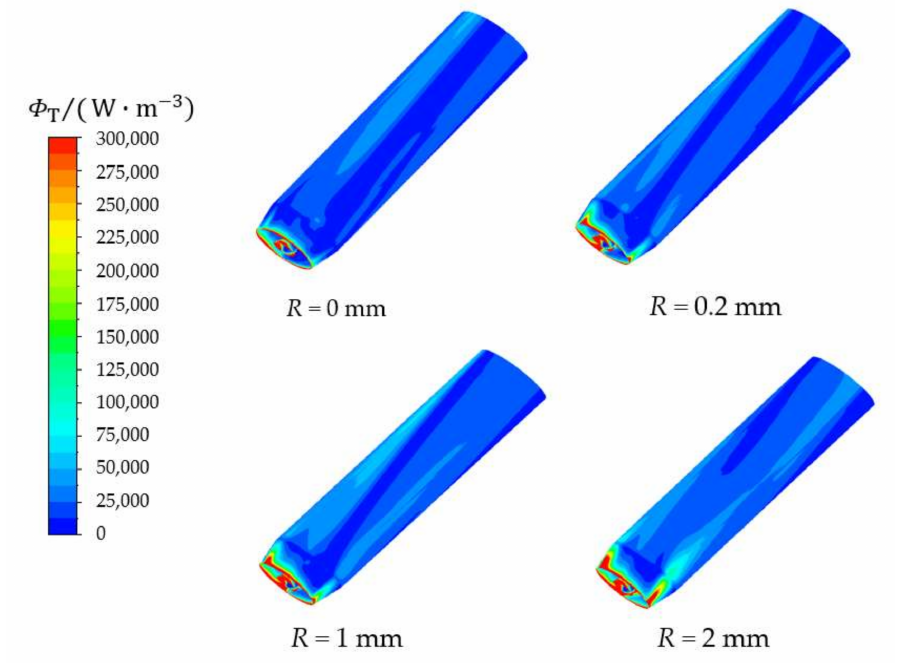
Figure 22. Distribution of internal dissipation rate in outflow passage under turbine